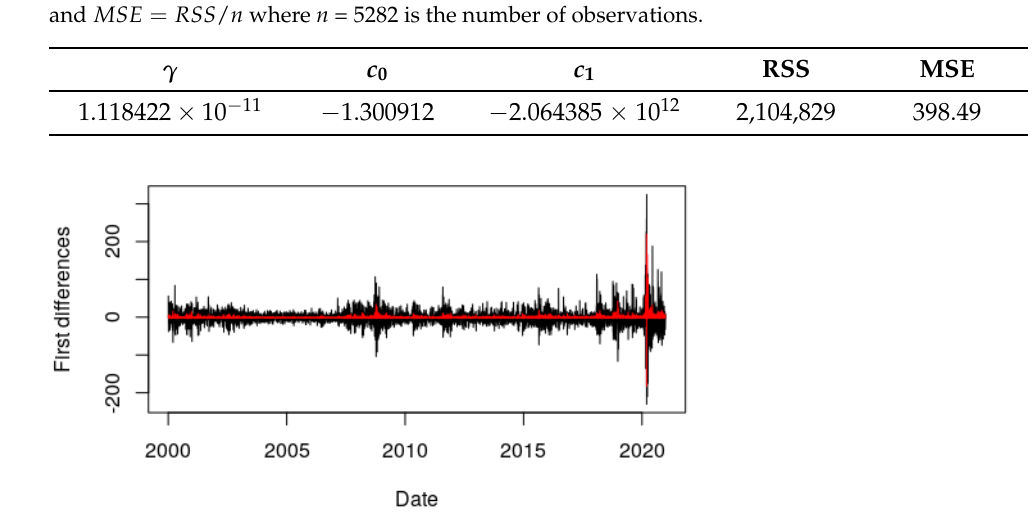
Figure 6. First differences in black, approximation in red. Implementation using pattern